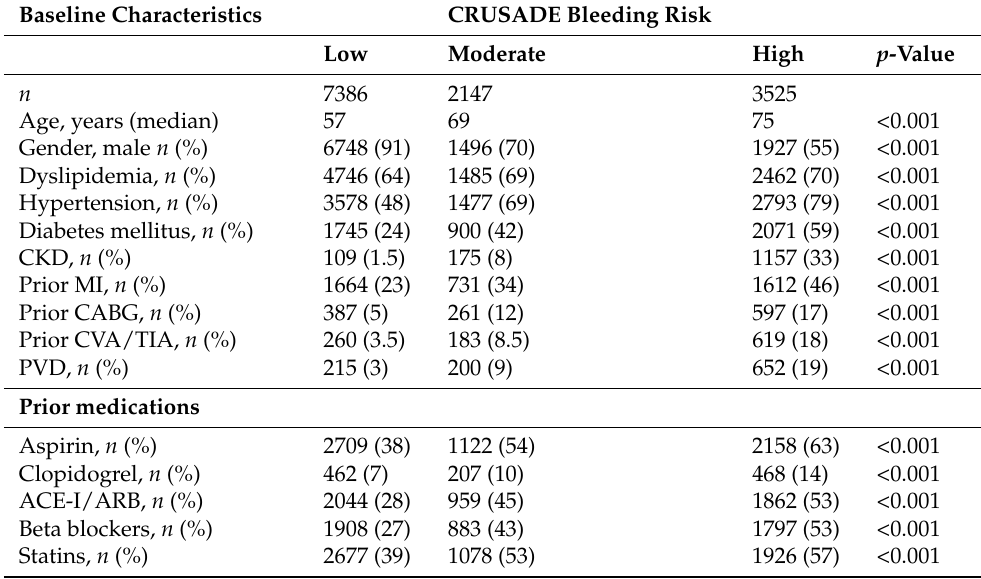
Table 1. Baseline characteristics according to bleeding risk.